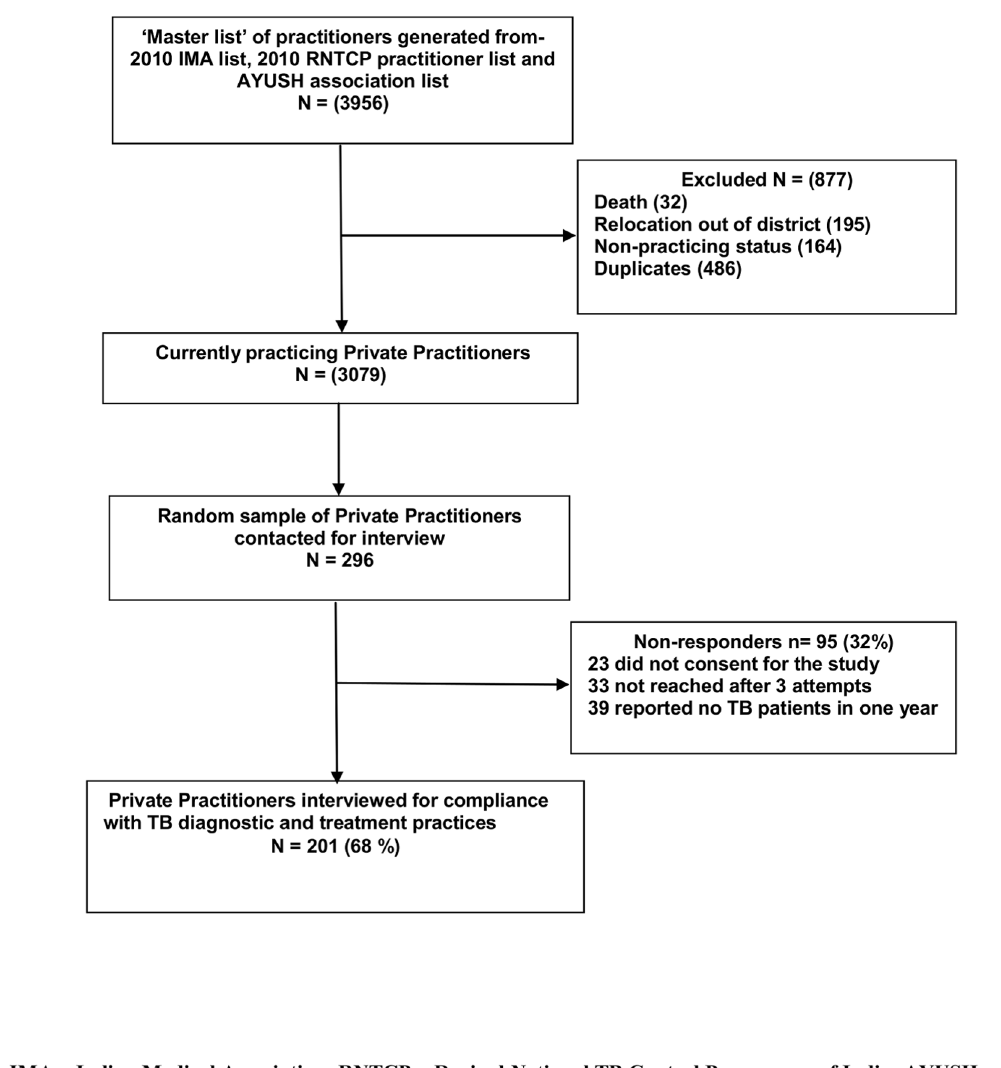
Figure 3. Selection of Private Practitioners (study participants) in Visakhapatnam, Andhra Pradesh. A master list of 3956 private practitioners was prepared from the year 2010 list of IMA*, RNTCP*** practitioners and AYUSH**. Of these 877 were excluded due to death, 195 relocated out of district, 164 non-practicing status and 486 were duplicate entries. Of the remaining 3079 practitioners, a random sample of 296 were contacted for interview. Of those contacted, 95 (32%) were non-responders, 23 did not consent for the study, 33 not reached after 3 attempts and 39 reported seeing zero TB**** patients in one year. So, Private Practitioners interviewed for compliance with TB diagnostic and treatment practices were N=201 (68%). IMA*=Indian Medical Association; RNTCP**=Revised National TB Control Programme of India; AYUSH***=- Ayurveda, Unani, Siddha, Homeopathy; TB****=tuberculosis.